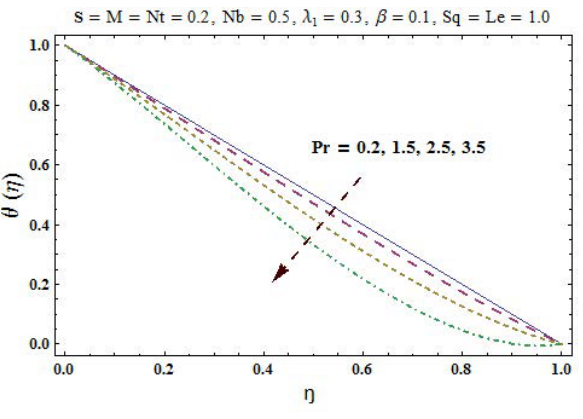
Figure 6. Plots of θ ( η ) for Pr .